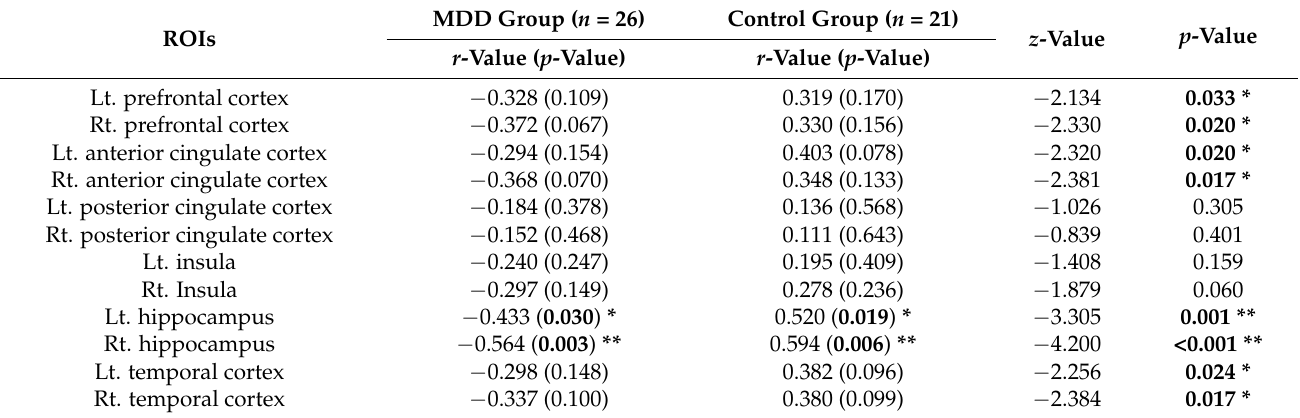
Table 4. Correlation coefficients between regional [ 11 C]PK11195 BP ND values and serum adiponectin levels with BMI as a covariate and between-group comparisons of the correlation